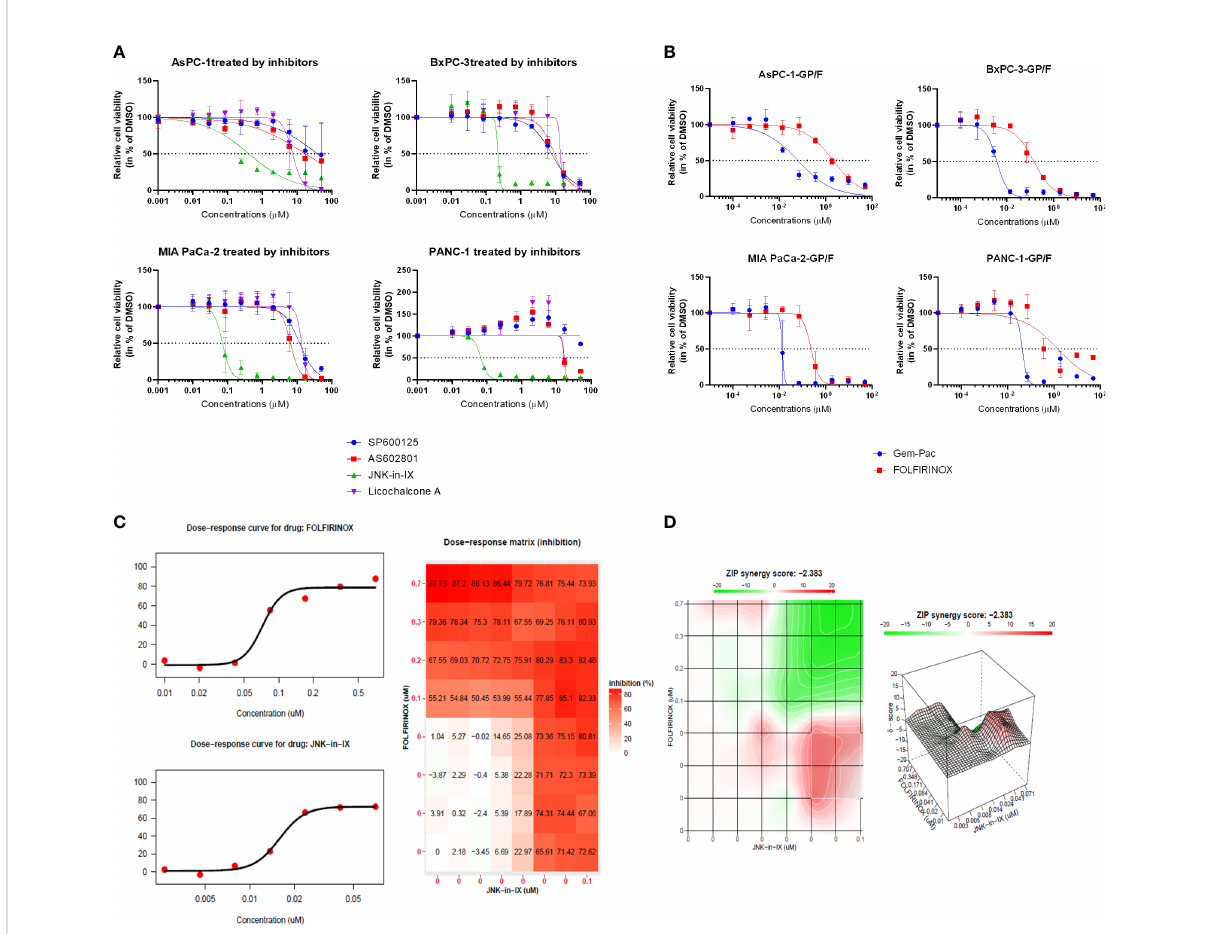
FIGURE 1 Targeting pancreatic cancer cells. (A, B) 500 cells per well were seeded in 384-well plates containing 50 m l of complete medium. 24 h after seeding, increasing concentrations of JNK inhibitors (A) and chemotherapeutics (B) dissolved in DMSO were added in triplicate using the Tecan D300e Dispenser. DMSO was normalized to the highest concentration (0.5%, v/v). Cell viability was evaluated 5 days after treatment using CellTiter-Glo. Results shown are means of 3 independent experiments. (C, D) Combination treatment with JNK-in-IX and FOLFIRINOX in MIA PaCa-2. Data were calculated and visualized using SynergyFinder 2.0. Results are means of 3 independent experiments. With a ZIP score of less than -10, the interaction between two drugs is likely to be antagonistic; from -10 to 10: the interaction is likely to be additive, and for scores larger than 10, the interaction is likely to be synergistic. GP: Gemcitabine-Paclitaxel (Gem-Pac): the combination of Gemcitabine and Paclitaxel with the ratio of 1:0.04 (c/c); F FOLFIRINOX: the combination of SN-38, Oxaliplatin and 5-FU with the ratio of 1:0.8:80.95